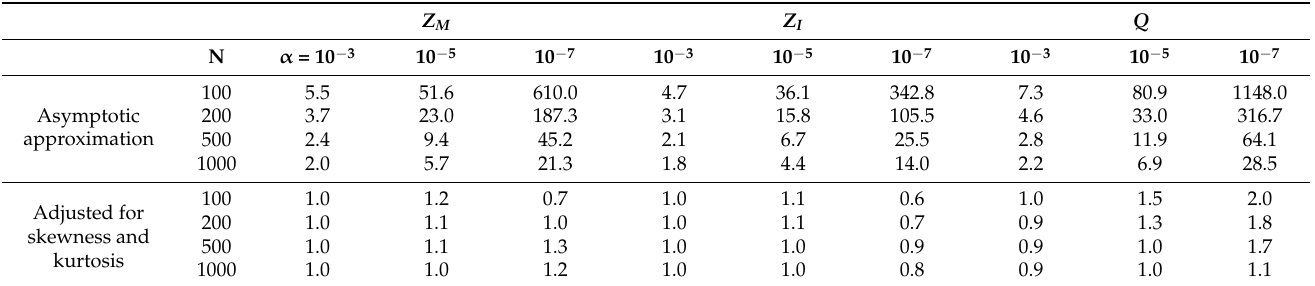
Table 1. Type-I error rates estimated based on 10 8 simulations. Minor allele frequency = 20%. Simulations were based on the weighted UniFrac distance matrix of the gut microbiome data from the American Gut Project. Reported are the type-I error inflation factor. A value greater than 1 indicates an inflated type-I error.